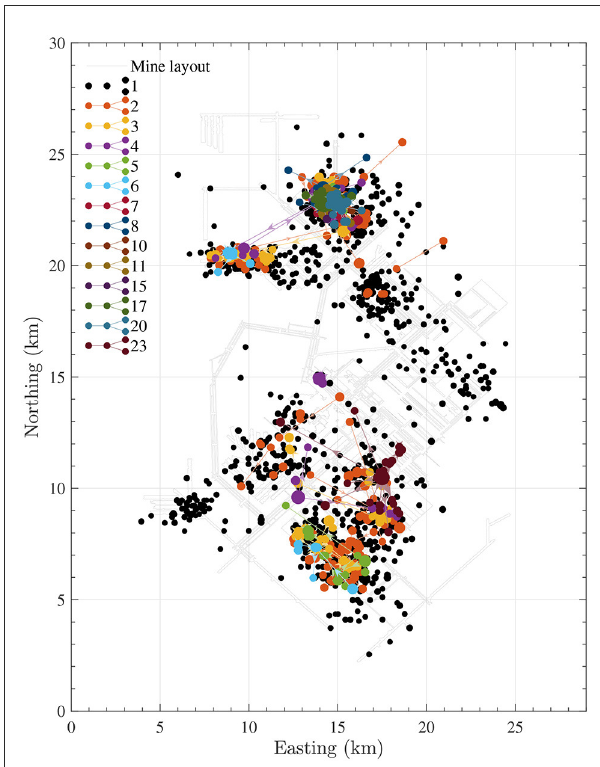
FIGURE12 The spatial distribution of all the clusters identified using the NND method by using the threshold log 10 ( η thresh ) with respect to the mine layout. Black solid circles indicate the singleton events. The colored solid circles are all clusters with more than one